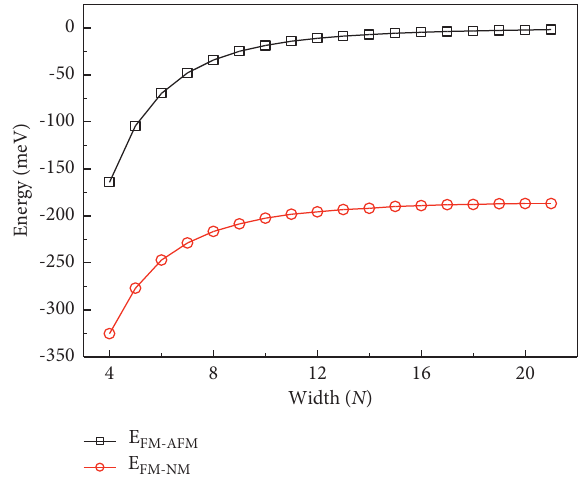
Figure 2: The energy difference E